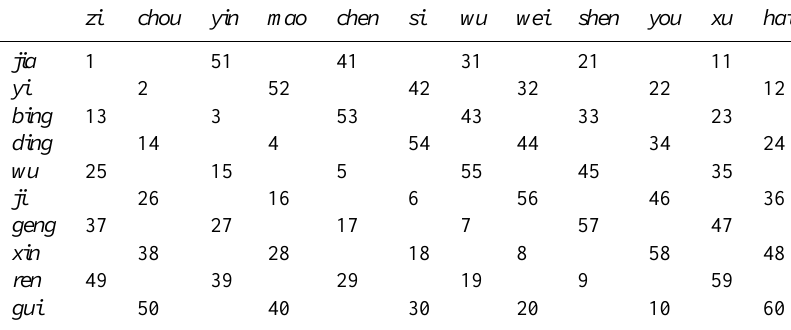
Table A1. The Chinese sexagenary cycle (with the day names written in hanyu pinyin ). zi chou yin mao